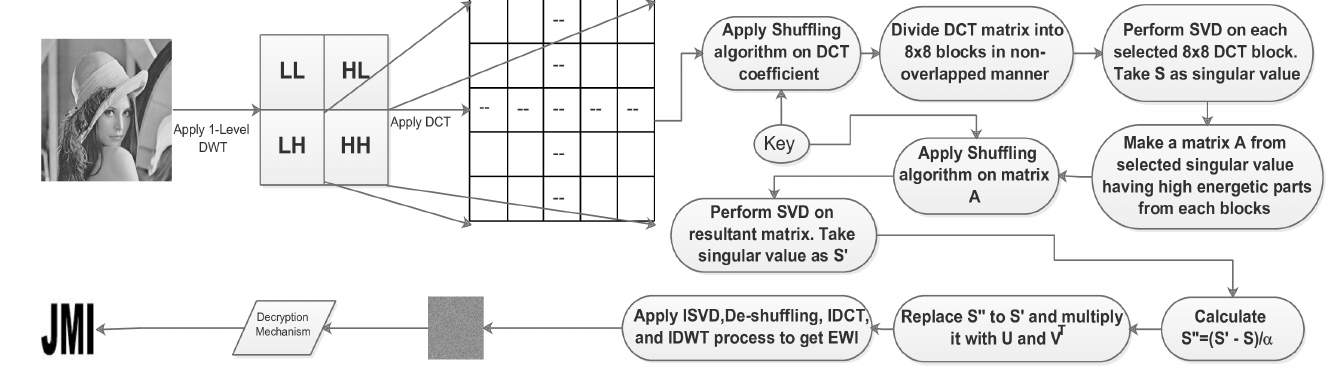
Fig. 5. The extracting process block